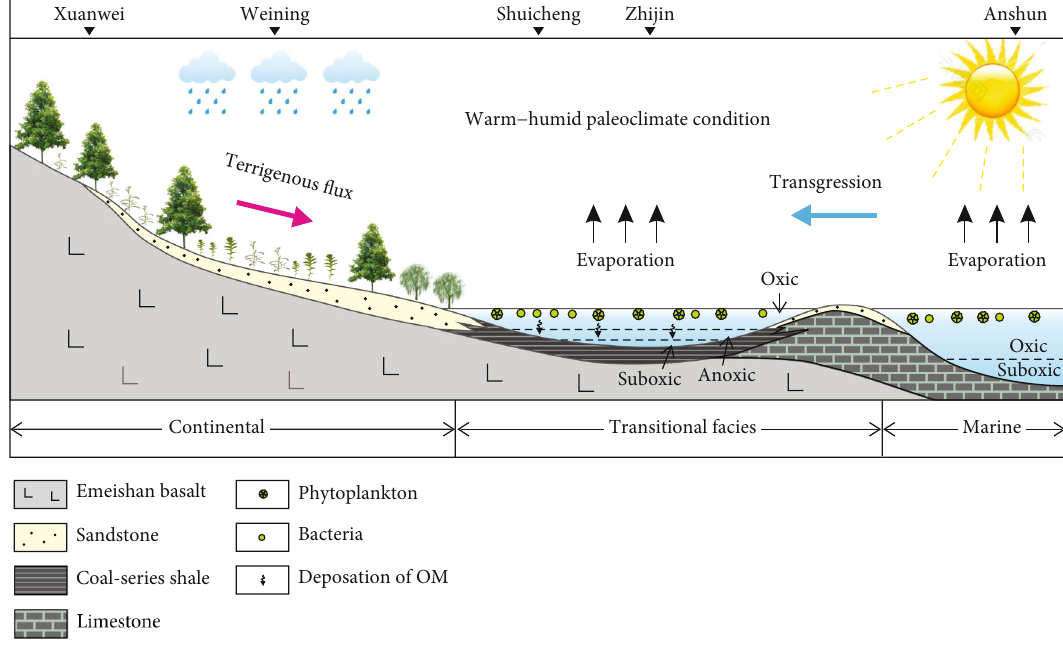
Figure 9: Organic matter enrichment model of the Longtan coal series